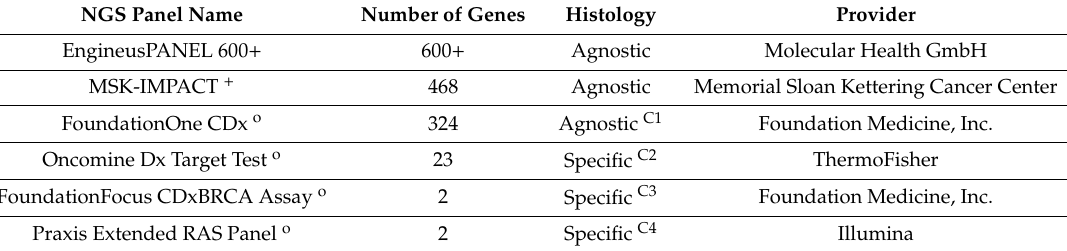
Table 1. Sample selection of key next generation sequencing (NGS)